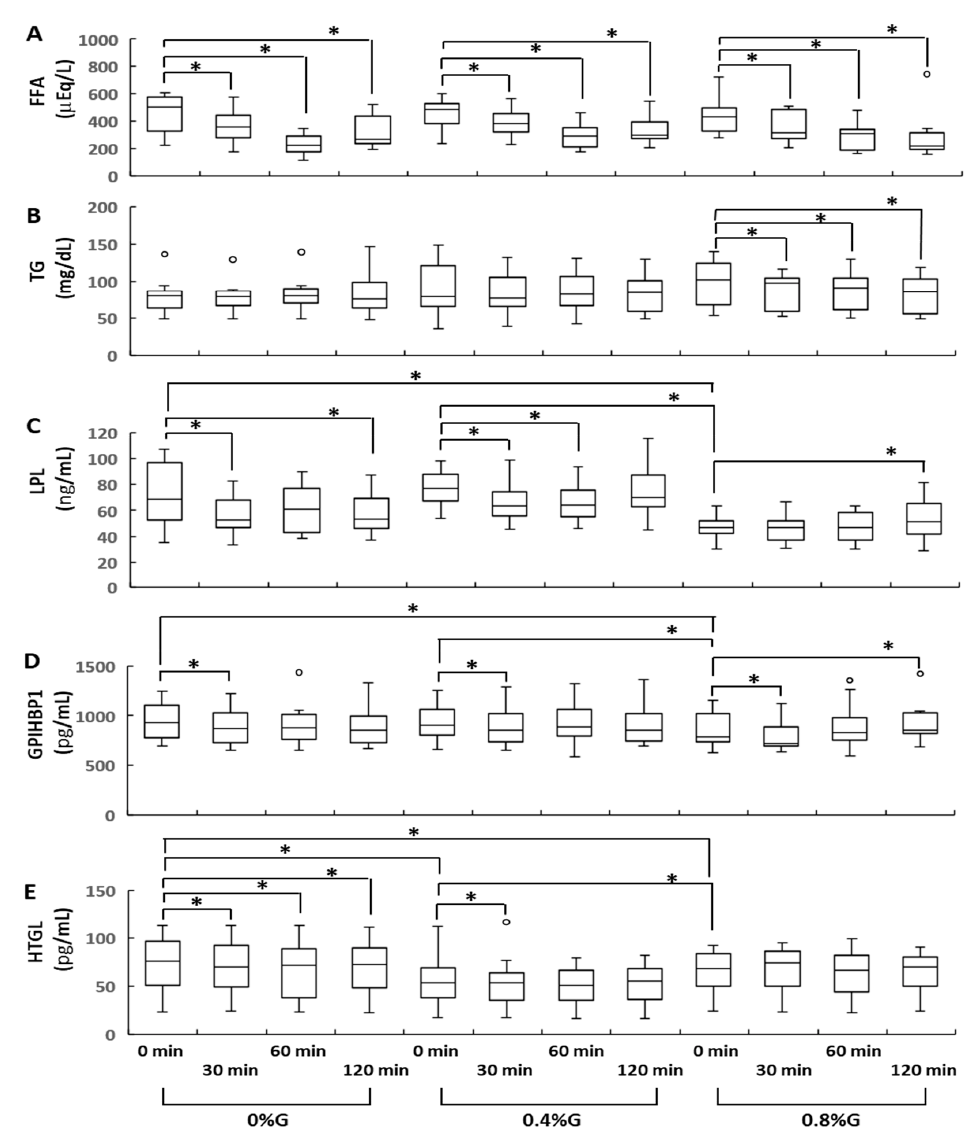
Figure 2. Sequential changes in the serum concentrations of FFA ( A ), TG ( B ), LPL ( C ), GPIHBP1 ( D ), and HTGL ( E ) during the gruel tolerance test. 0%G, rice gruel containing no Konjac glucomannan powder; 0.4%G, rice gruel supplemented with 0.4% Konjac glucomannan powder; 0.8%G, rice gruel supplemented with 0.8% Konjac glucomannan powder. Data are presented as median values with a 25th–75th percentile range. * indicates statistical significance ( p < 0.05). FFA, free fatty acid; GPIHBP1, glycosylphosphatidylinositol-anchored high-density lipoprotein-binding protein 1; HTGL, hepatic triglyceride lipase; LPL, lipoprotein lipase; TG,